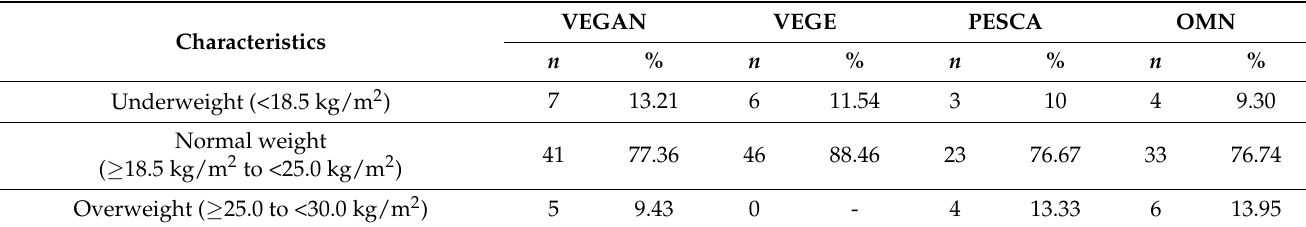
Table 5. Characteristics of the study participants concerning the BMI